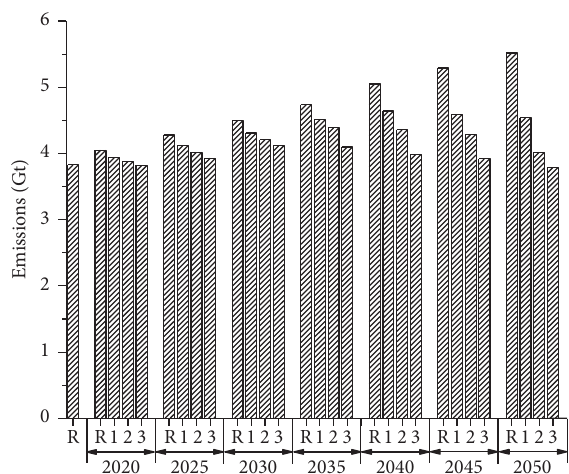
Figure 5: CO 2 emissions of power